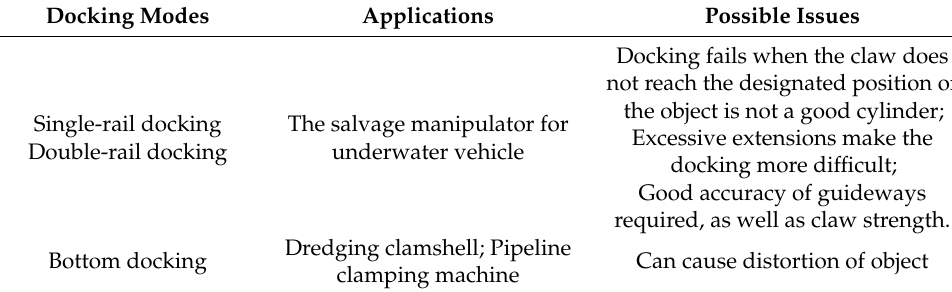
Table 4. Comparison between rail docking and bottom